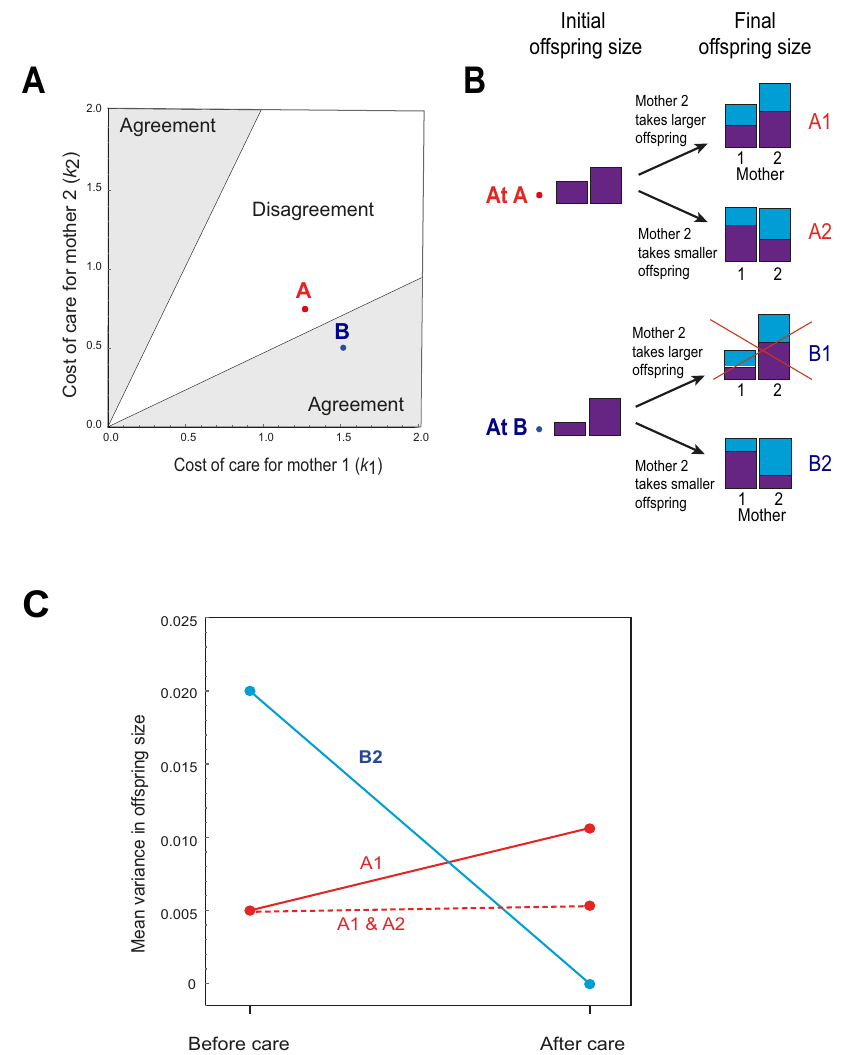
Fig. 1 Model of parental investment from behind a veil of ignorance. A Zones of agreement and disagreement over which mother cares for which offspring (see main text), when b ( x ) = x (1 − x /2) (for x ≤ 1) and c ( k;y ) = k y 2 . Two illustrative sets of parameter values are marked: point A (in the zone of disagreement) where we assume that initial asymmetries between parents and between offspring are smaller ( k 1 = 1.25, k 2 = 0.75, x hi = 0.25, x lo = 0.15) and point B (in the zone of agreement) where initial asymmetries between parents and between offspring are larger ( k 1 = 1.5, k 2 = 0.5, x hi = 0.3, x lo = 0.1). B The predicted prenatal (purple shading) and postnatal (light blue shading) investment received by each offspring given each of the two sets of parameter values A and B. For each set of parameter values A and B we show the outcomes when (i) the inferior carer, here mother 1, looks after the initially smaller offspring (outcomes A1 and B1), and when (ii) mother 1 looks after the initially larger offspring (outcomes A2 and B2). At point A, the mothers disagree over who should care for whom, so neither outcome is universally preferred; at point B, outcome B2 is preferred by both parents, so outcome B1 is never chosen and is crossed out. C Variance in offspring size before and after postnatal investment at point A, assuming either outcome A1 (solid red line) or that outcomes A1 and A2 are equally probable (dashed red line), and at point B, assuming the mutually preferred outcome B2 (solid blue should level out the initial inequality among offspring (outcome B2 in Fig. 1B; solid blue line in Fig. 1C). Paradoxically, therefore, we predict that behind the veil of ignorance, greater inequalities between parents lead to a fairer outcome for offspring.